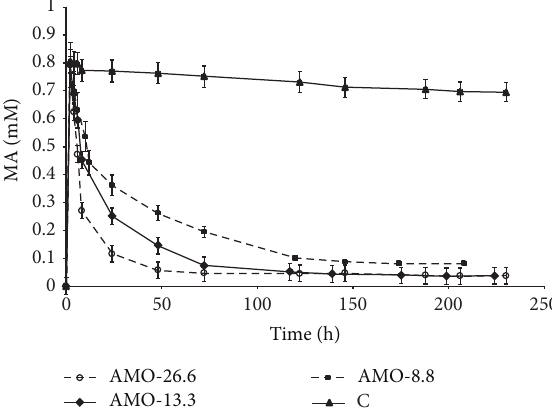
oxidation of MA in the 7 mLmin −1 air flow with 10ppm MA inlet concentration by immobilized AMO at various loadings on CA gel: 26.6 U g −1 CA, AMO-26.6; 13.3U g −1 CA, AMO-13.3; and 8.8 Ug −1 CA, AMO-8.8. C (control)—blank beads of CA-gel tested at the same inlet